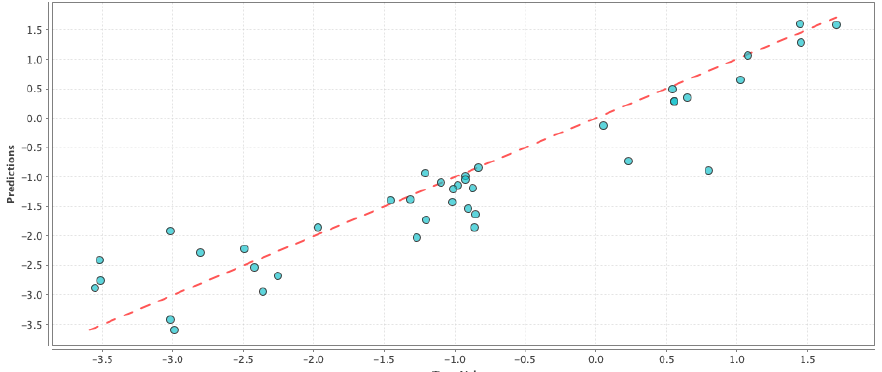
Figure 5. Result on Test Set For Support Vector Machine using Model 6 from Table 3. The x-axis represents the true or the actual PDSI values and the y-axis represents the predicted PDSI values. Each small blue circle in the figures is represented by the tuple ( PDSI actual , PDSI pred ). The red dashed line is the reference line to test the model